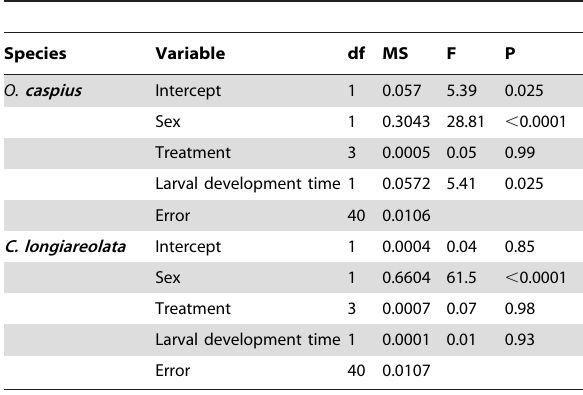
Table 2. The effect of sex and initial larval abundances of larval development time.